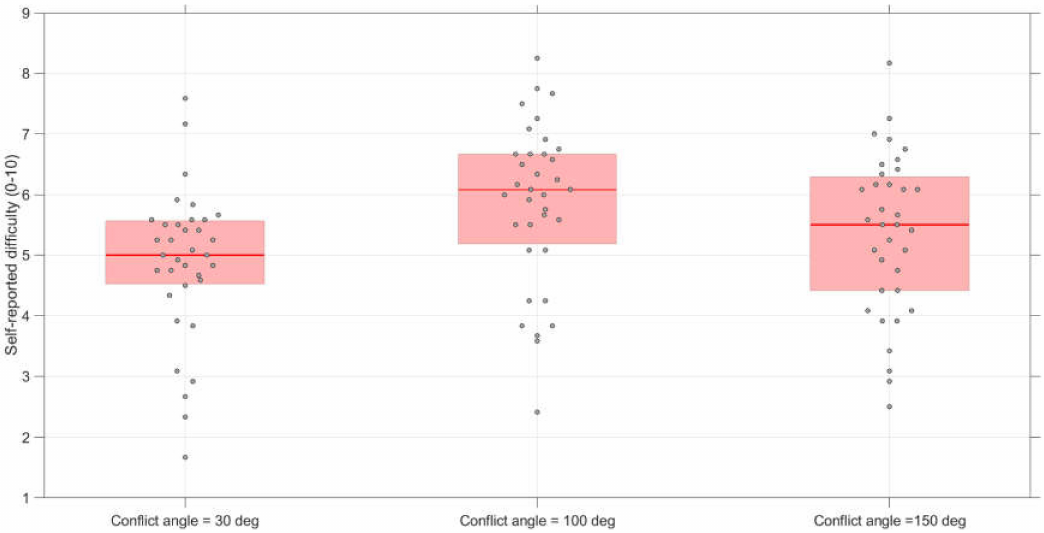
Figure 6. Boxplots of the self-reported di ffi culty scores per conflict angle. The score for each participant represents the average of 12 scenarios (conflict scenarios and non-conflict scenarios